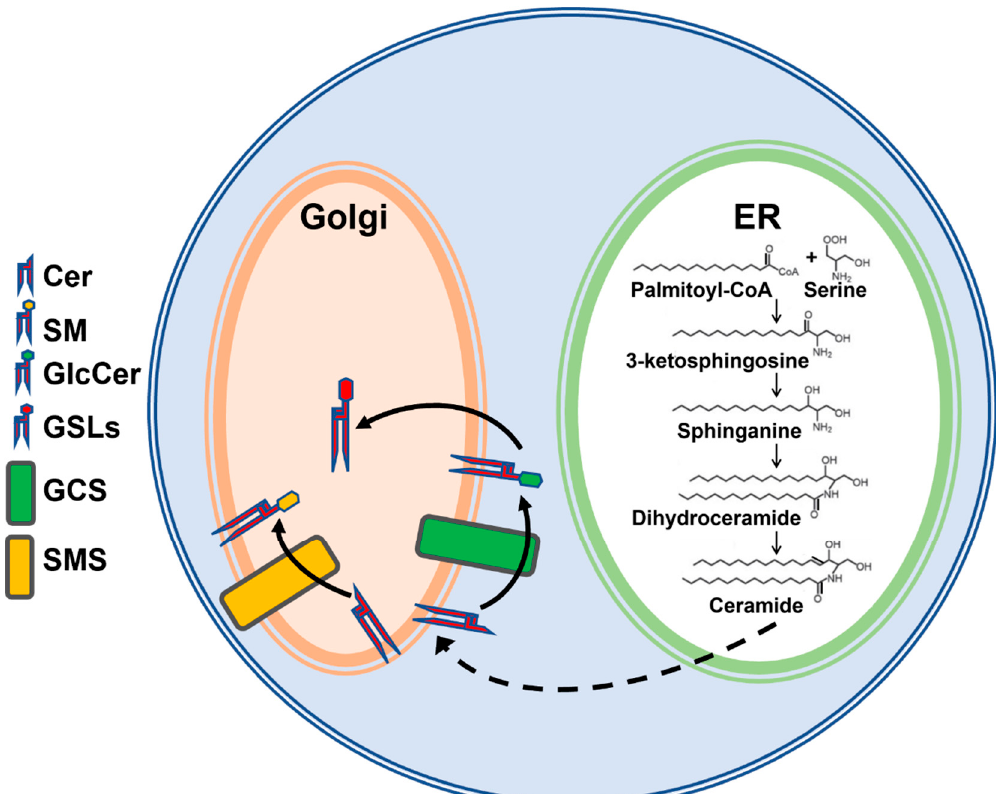
Figure 1. Simplified schematic representation of sphingolipid biosynthesis. De novo sphingolipid synthesis is initiated by the condensation of palmitoyl-CoA and serine in the endoplasmic reticulum (ER), leading to the synthesis of ceramide (Cer). Cer is delivered to the Golgi by transport proteins or vesicular transport for synthesis of sphingomyelin (SM) on the lumenal side of Golgi by sphingomyelin synthase (SMS) or glucosylceramide (GlcCer) on the cytosolic side of Golgi by glucosylceramide synthase (GCS). GlcCer is then translocated to the Golgi lumen for the biosynthesis of complex glycosphingolipids (GSLs).